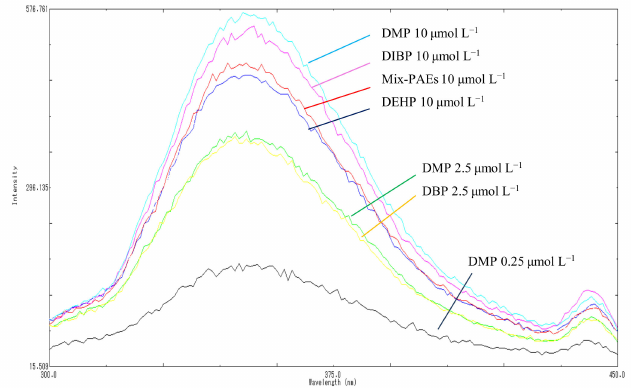
Figure 3. Fluorescence emission spectrum of individual and mixed